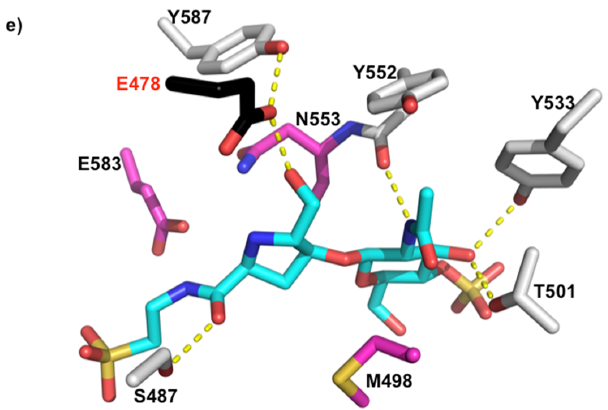
Figure 2. ( a ) Bulgecin A, a sulphonated N -acetyl- D -glucosamine unit linked to a 4-hydroxy-5-hydroxymethylproline ring by a β -glycosidic linkage. Crystal structure of LtgA in complex with bulgecin A at 1.78 angstroms; ( b ) Domain organization of LtgA in which the helices are represented by cylinders, and the active site residues are illustrated in a stick model. Active site residues are mainly colored in grey and catalytic residue in black for contrast. Bulgecin A is colored in yellow. In this front view, bulgecin A (yellow) is binding in the putative active site of LtgA; ( c ) Schematic of bulgecin A in the active site of LtgA; ( d ) Noncovalent interactions between bulgecin A and conserved residues in the active site of LtgA (Figure S2 alignment). Water molecules are represented by red spheres and further highlighted with blue arrows; ( e ) Close-up of the active site of bulgecin A in the active site of Slt70. For contrast to Figure 2d, bulgecin A is colored in blue. Conserved residues that are making interactions in the LtgA-bulgecin A complex are colored in pink. In the soluble lytic tranglycosylases (Slt)70-bulgecin A complex a solvent model is undefined because it is at lower resolution 2.8 angstroms